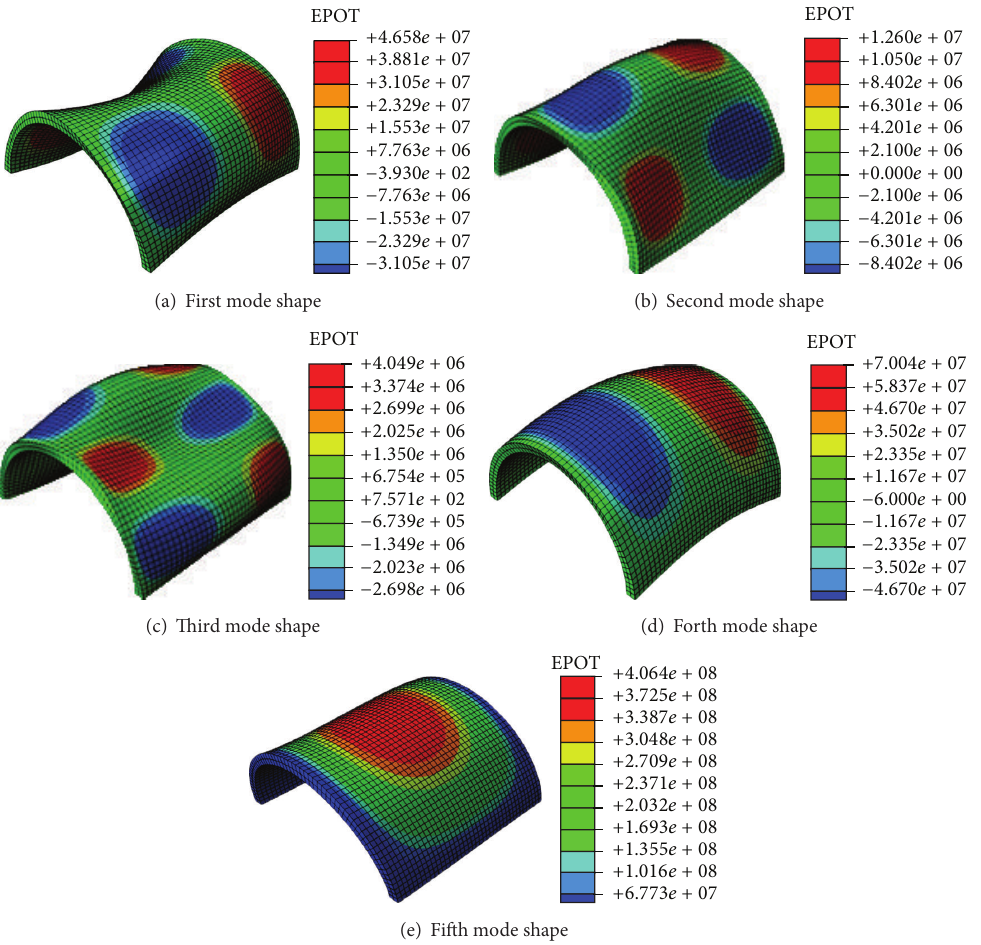
Figure 2: Mode shapes of the five first natural frequencies.